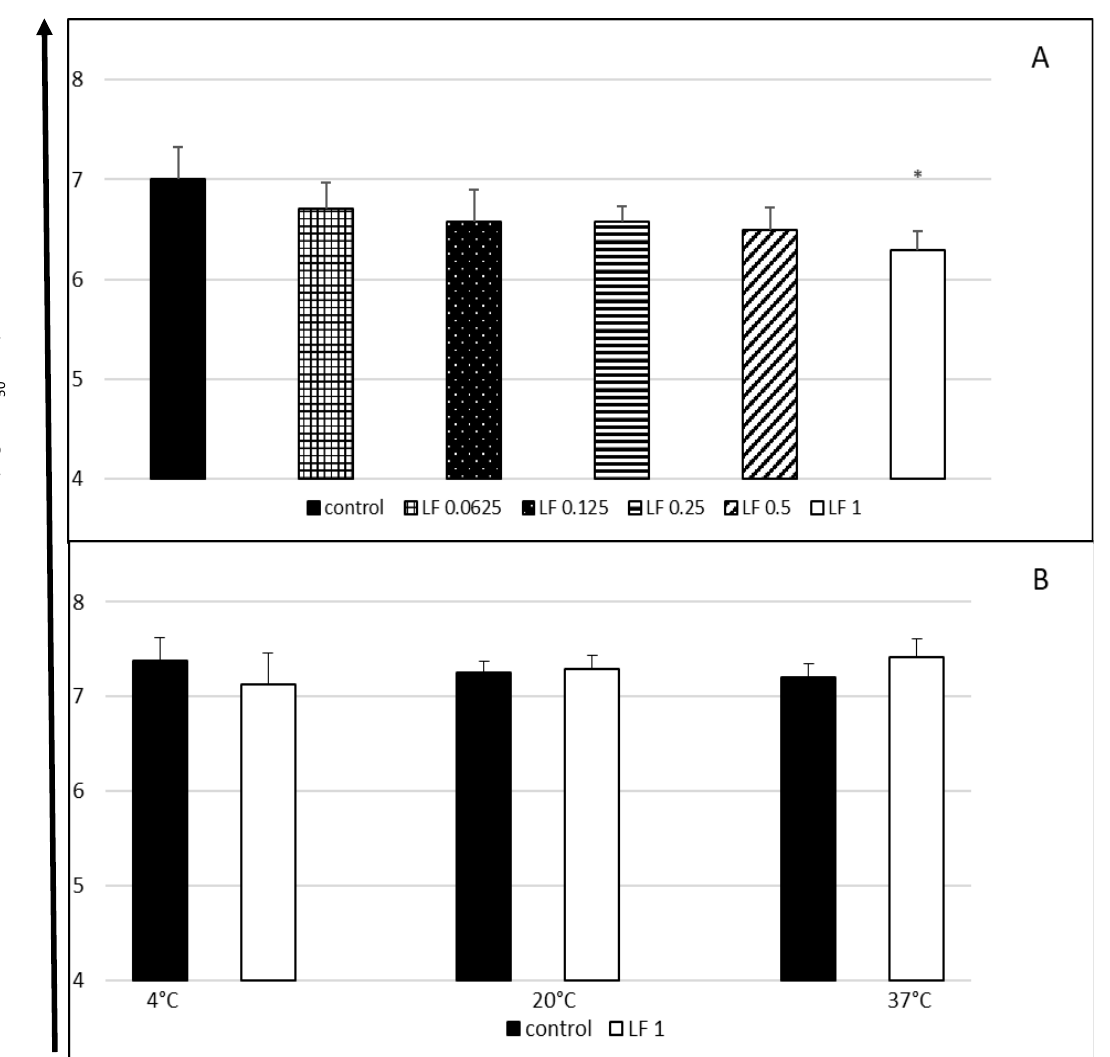
Figure 1. Cytophatic effect inhibition ( A ) and virucidal activity ( B ) of bovine lactoferrin against enterovirus E. The 50% endpoint virus titres (CCID 50 ) were determined using the Reed and Muench method. Lactoferrin (LF) concentrations in mg/mL; control: untreated virus. Data presented as means ±SD (standard deviation) for three independent experiments ( n = 3). Statistically significant differences between control and treatments marked with an asterisk at * p < 0.05.